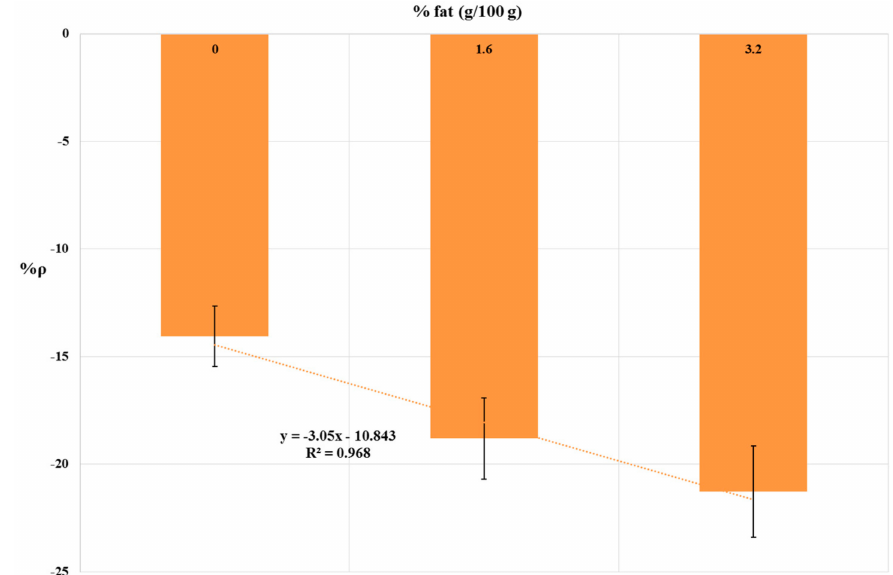
Figure 5. Dose-effect histogram for 2 h exposure to 10 ppb simazine in commercial whole, semi-skimmed and skimmed UHT milk. %RSD ≤ 15%; ANOVA testing using Randomized Block Design was applied for statistical differences between means values of ∆ ppm O 2 exp and ∆ ppm O 2 blk ( p <